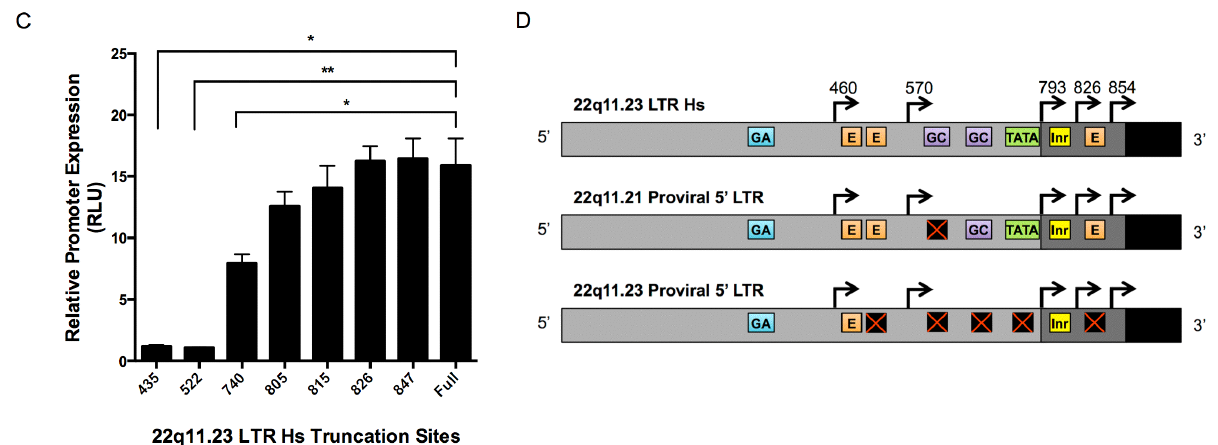
Figure 5. HML-2 Promoter Expression in Tera-1 Cells. ( A ) Comparison of the relative transcript expression level (FPKM; black) for a provirus and its corresponding relative luciferase expression level in Tera-1 cells transfected with a vector containing a luciferase reporter gene downstream of the indicated proviral 5’ LTR. LTR activity is expressed as relative light units (RLU; gray) normalized to a control construct with a Renilla luciferase gene driven by an SV40 promoter. The relative promoter activities of the LTR Hs located 551 bp upstream from the 22q11.23 provirus, the 5’ LTR 5B of the 22q11.23 provirus and the 5’ LTR Hs of six other expressed proviruses in Tera-1 cells are shown. ( B ) Schematic of the 22q11.23 LTR Hs, showing the U3, R and U5 regions. Predicted transcriptional start sites are indicated with black arrows and nucleotide position. Colored boxes indicate previously described promoter element motifs [62–64]. Lines below the LTR diagram indicate the regions included in each truncated LTR construct, and numbers to the right of each line indicate the nucleotide position at which the LTR was truncated. GA, GA rich motif (nt 379–386, sequence GGGAAGGG); E, enhancer box (nt 465–476, sequence TTGCAGTTGAGA; nt 485–496, sequence AGGCATCTGTCT; nt 832–843, sequence CTCCATATGCTG); GC, GC rich motif nt 759–763, (sequence CCCCC; nt 602–606, sequence GGCGG); TATA, TATA box (nt 790–797, sequence AATAAATA); Inr, initiator element (nt 807–812, sequence CTCAGA). Cartoon is not drawn to scale. ( C ) Relative promoter expression levels of truncated 22q11.23 LTR Hs constructs in Tera-1 cells (Kruskal-Wallis, * p < 0.05, ** p < 0.01). All luciferase experiments were conducted